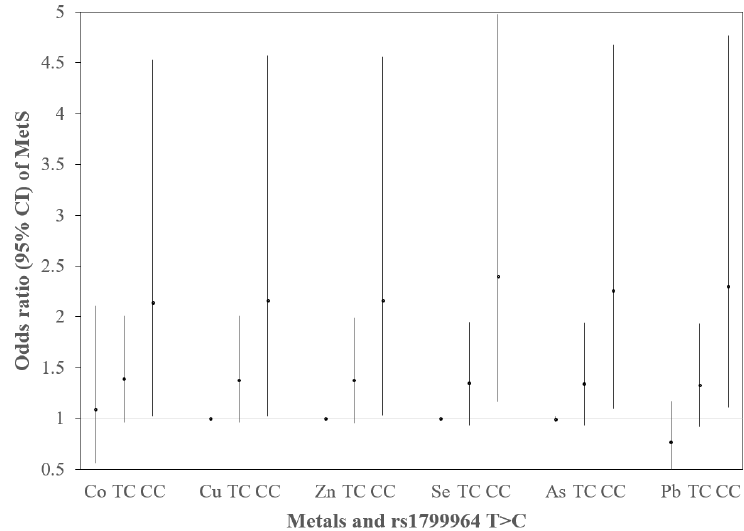
Figure 4. ORs (95% CIs) of MetS for rs1799964 T>C by metals. The logistic regression model was built as logit [p(MetS)/1 − p(MetS)] = β 0 + β M, j M j + β SNP,1 i SNP 1 i + β SNP,2 i SNP 2 i + β c Covariates + ε . Adjusted covariates included age, gender, smoking, and drinking alcohol. The prevalence of MetS with metals was increased in Cu only (OR = 1.001, 95% CI: 1.000, 1.001). Genotype CC was associated with an elevated risk of MetS, and the OR was 2.14 (95% CI: 1.02, 4.53) adjusting for Co, OR = 2.16 (95% CI: 1.02, 4.57) adjusting for Cu, OR = 2.16 (95% CI: 1.03, 4.56) adjusting for Zn, OR = 2.40 (95% CI: 1.16, 4.98) adjusting for Se, OR = 2.26 (95% CI: 1.09, 4.68) adjusting for As, and OR = 2.30 (95% CI: 1.11, 4.77) adjusting for Pb.